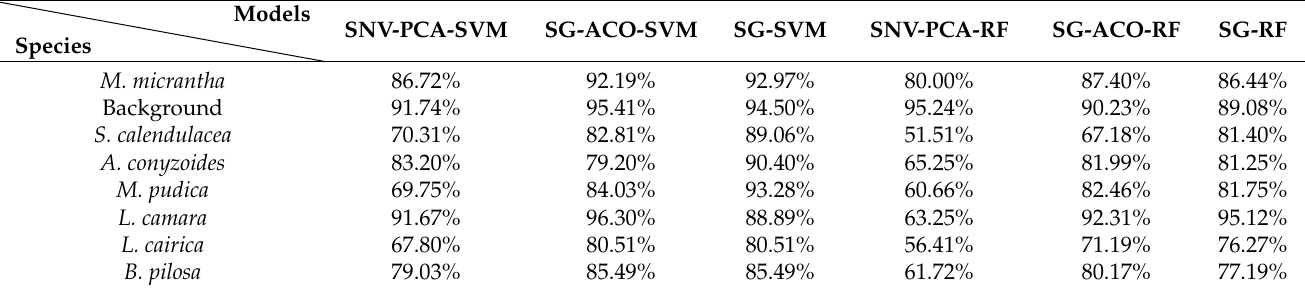
Table 2. Recognition accuracy of combined model for single